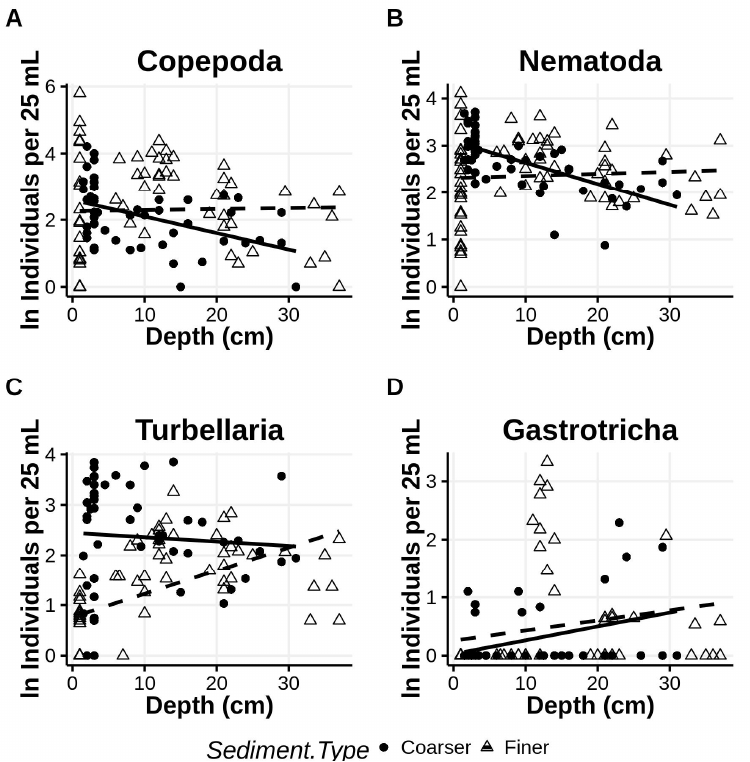
Figure 12. Abundances of major taxa ( A – D ) associated with finer and coarser sediments at depth into the beach from the sediment surface. Regression lines of ln abundance onto depth are partitioned by sediment type, coarser = solid, finer = dashed. Table 6. Parameters of linear regressions of ln-transformed abundances of major taxa onto depth with sediment type as a cofactor. When the interaction of the overall model is significant the parameters of the separate regressions (finer or coarser) are presented. ns — p > 0.05, *— p < 0.05, **— p < 0.01, ***— p <